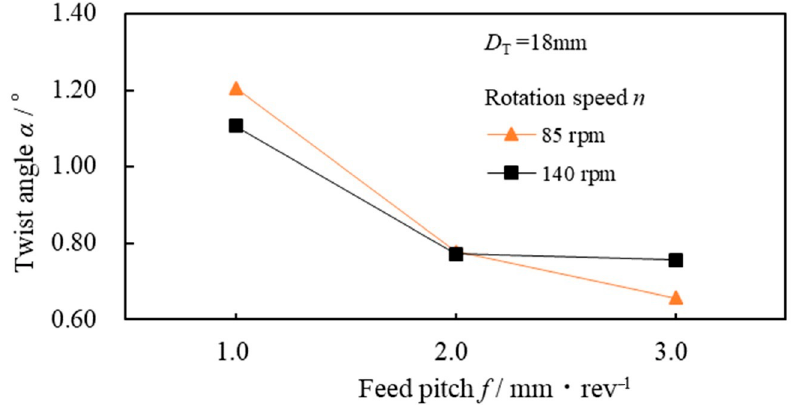
Figure 7. Relationship between the feed pitch and twist angle.